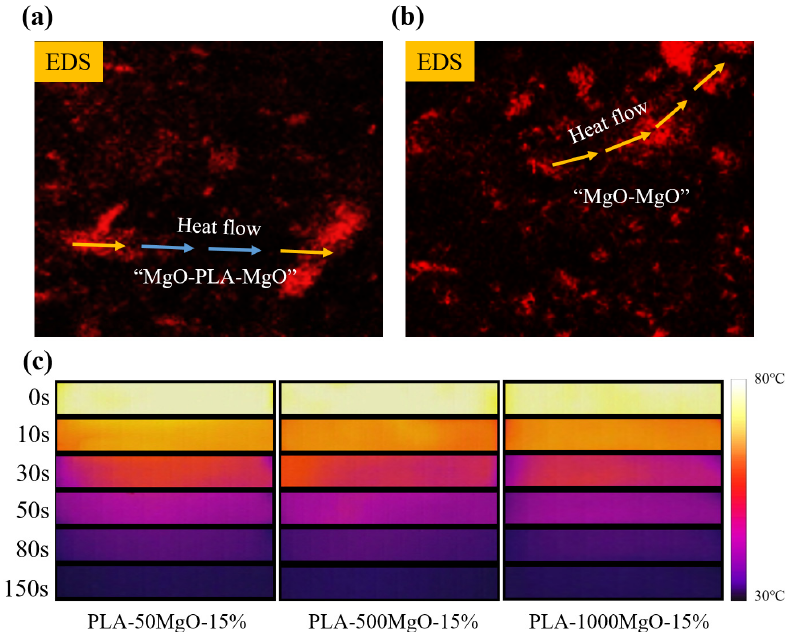
Figure 3. ( a ) EDS images with particle size of 50 nm and mass fraction of 5%; ( b ) EDS images with particle size of 1 um and mass fraction of 15%; ( c ) Infrared thermal images of different MgO/PLA composites.